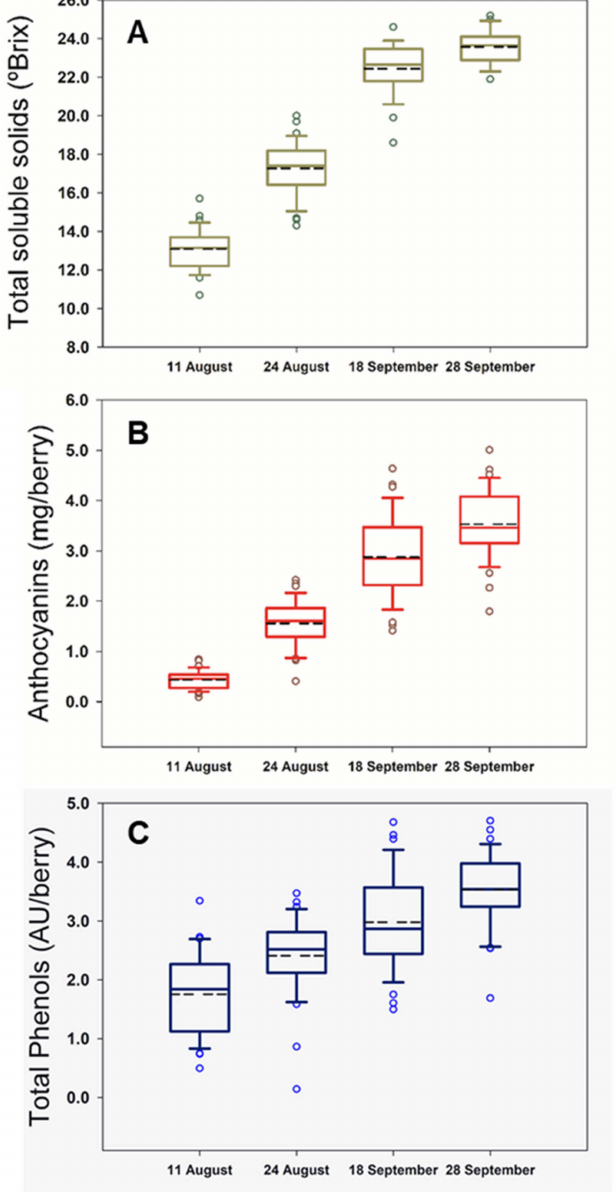
Figure 1. Box plots for total soluble solids ( A ), anthocyanins ( B ), and total polyphenols ( C ) during the four dates of the experimental study. Dashed lines represent mean